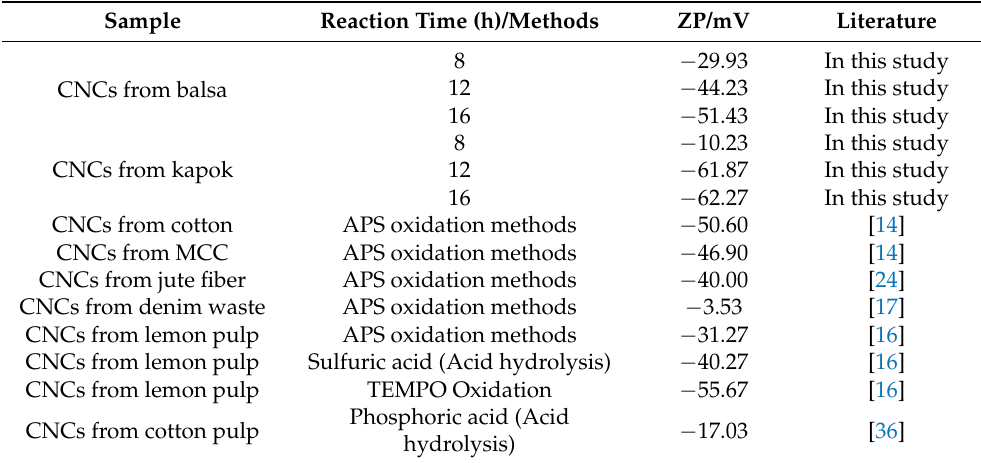
Table 2. Zeta potentials (ZPs) of the CNCs from balsa and kapok fibers.